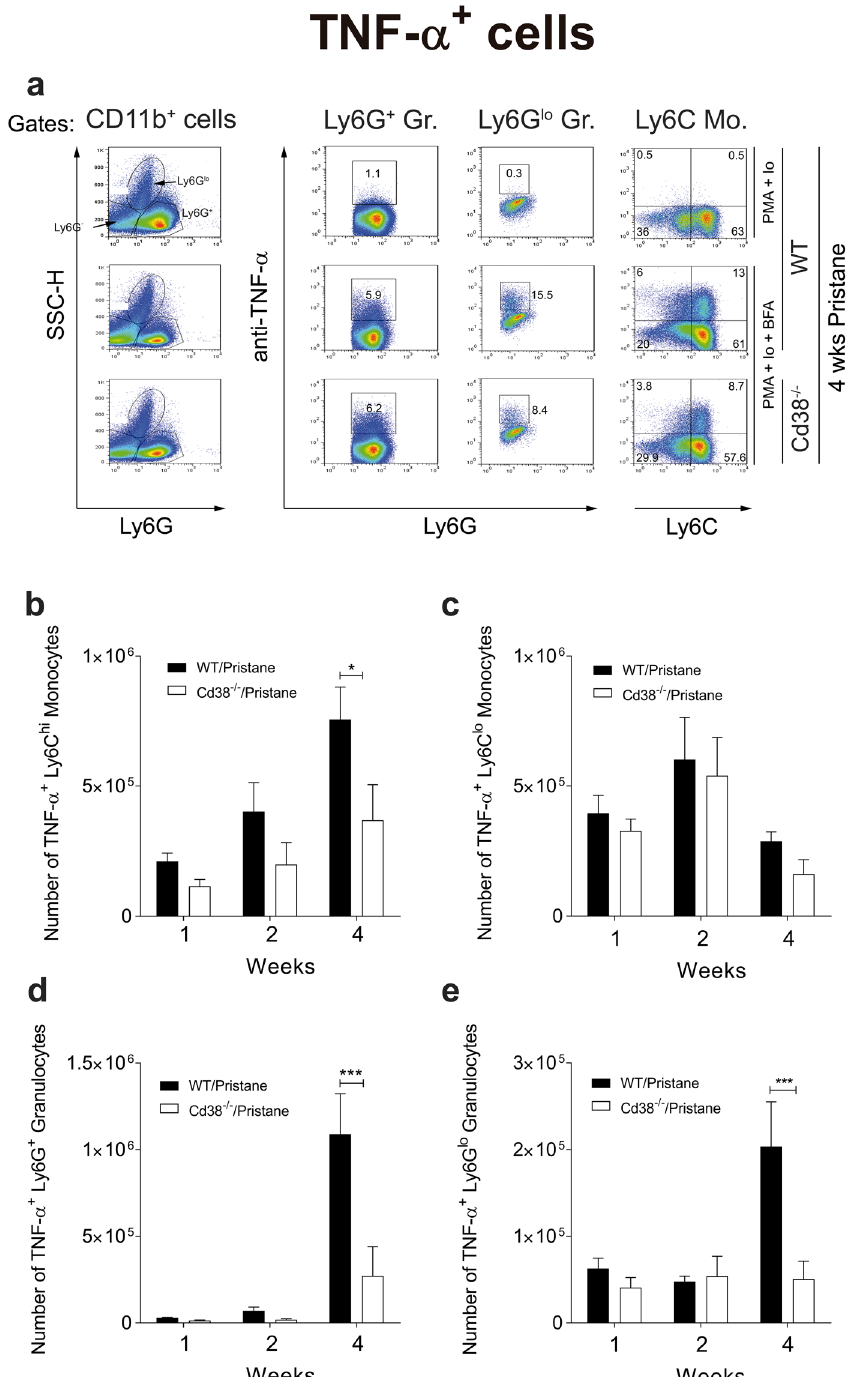
Figure 6. Defective recruitment of TNF- α -producing neutrophils and Ly6C hi monocytes to the peritoneum of pristane-treated Cd38 − / − mice. ( a ) Flow cytometric analyses of 4-weeks pristane-elicited PECs from WT and Cd38 − / − mice first surface-stained with anti-CD11b, anti-Ly6G and anti-Ly6C fluorescent-labelled antibodies, and then intracellularly stained for TNF- α as described in Methods. The three CD11b + peritoneal cell populations of interest were identified based on their level of Ly6G expression and side scatter (SSC) characteristics. The cell types were SSC lo Ly6G + granulocytes (neutrophils), and SSC hi Ly6G lo granulocytes (eosinophils) and SSC lo Ly6G − monocytes. Each cell type was stimulated with PMA, ionomycin and Brefeldin A (BFA). As a control, each WT cell type was incubated with PMA and ionomycin alone. The level of TNF- α expression in each cell type is shown, and the representative frequencies are included in each gate. ( b–e ) Numbers of TNF- α + Ly6C hi monocytes ( b ), TNF- α + Ly6C lo monocytes ( c ), TNF- α + Ly6G + granulocytes/neutrophils ( d ), and TNF α + Ly6G lo granulocytes/eosinophils ( e ) at 1-, 2- and 4-weeks post pristane treatment. Data are shown as the mean ± SE (n = 6–7 mice/group). All P values were determined by 2-way ANOVA with the Sidak’s multiple comparisons test. * P < 0.05 ** P < 0.01 *** P <